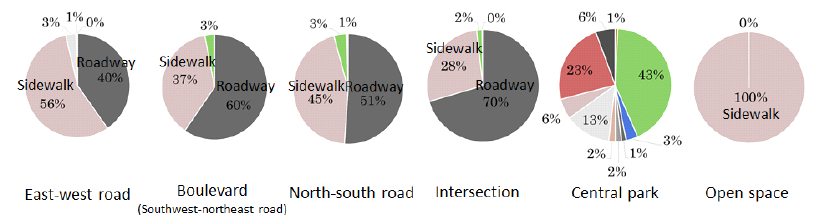
Figure 6. Area ratio of land cover materials in each study area.